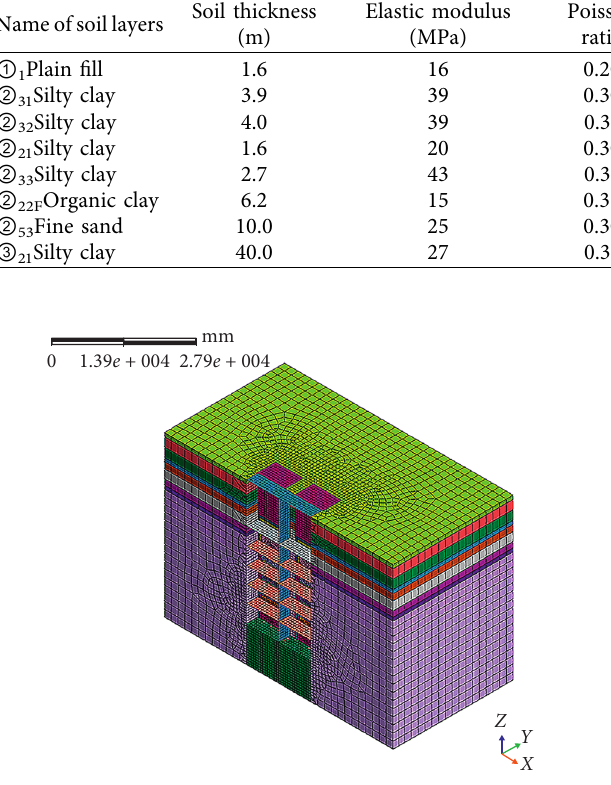
Figure 1: Three-dimensional numerical model.